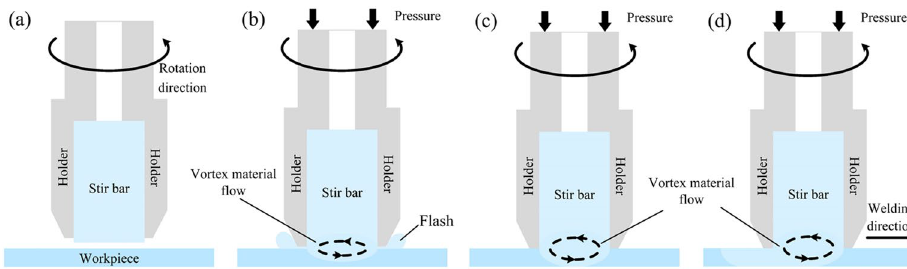
Figure 2. Schematic of the VFSW process procedure: ( a ) tool rotating; ( b ) tool plunging; ( c ) vortex material flow forming; ( d ) tool traversing.